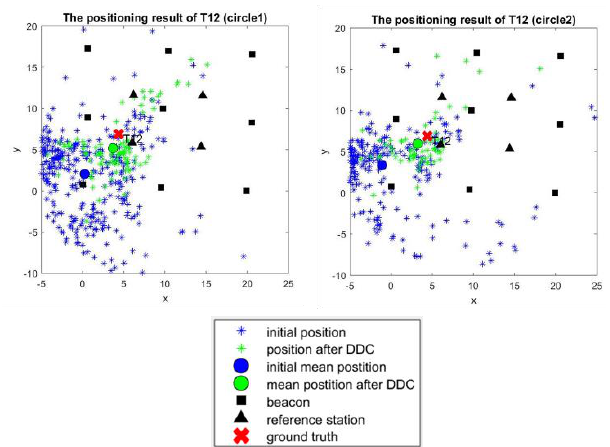
Figure 8. The BLE positioning results of participant 2